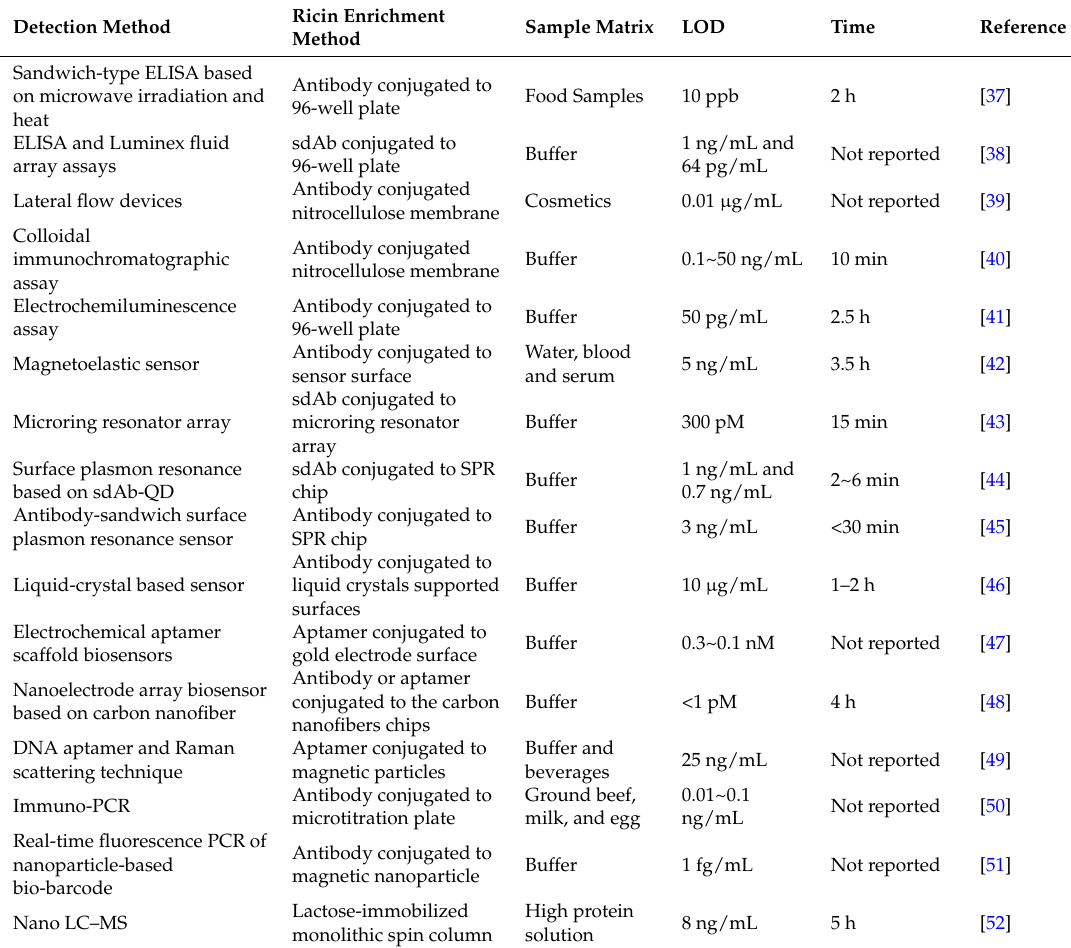
Table 6. Summary of ricin detection